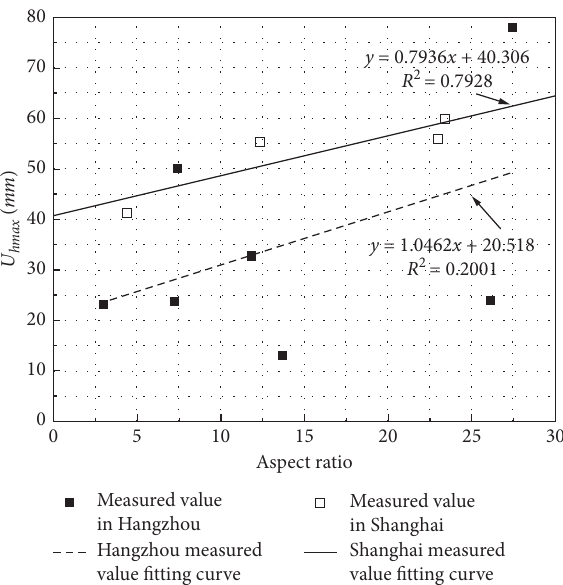
Figure 5: Relationship between aspect ratio and maximum lateral deformation of the